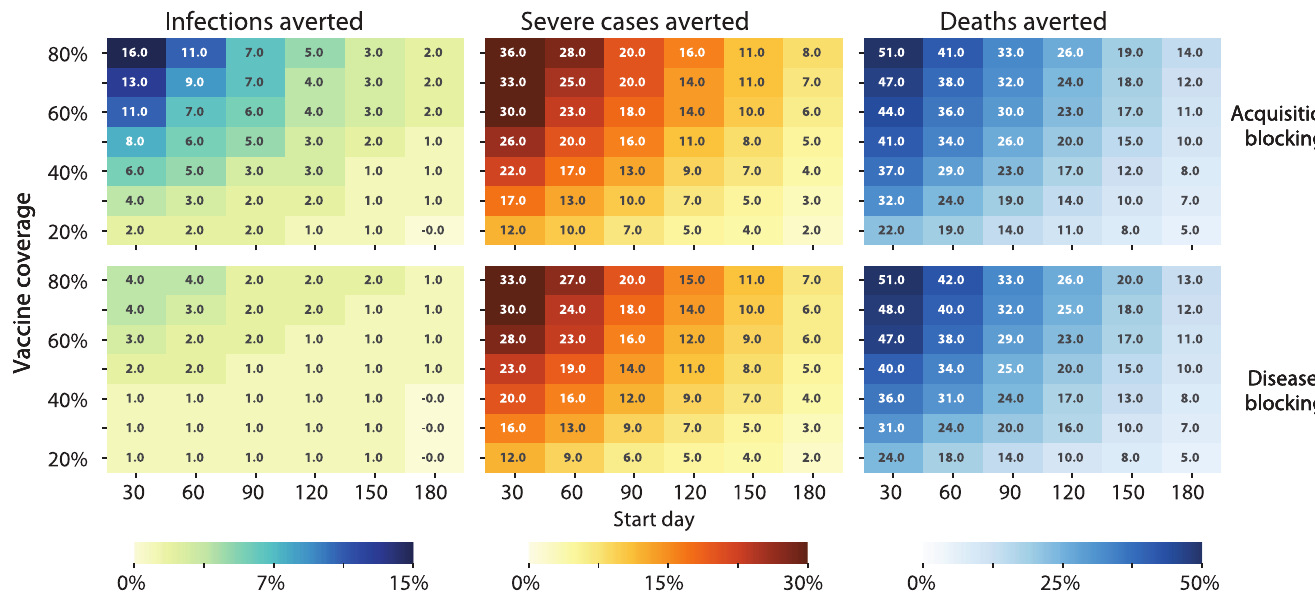
Fig 9. Vaccination campaign impacts by final coverage level and timing of vaccine introduction. Percentage reductions are shown for the respective cumulative indicator (infections, severe cases, or deaths) with respect to the baseline scenario without